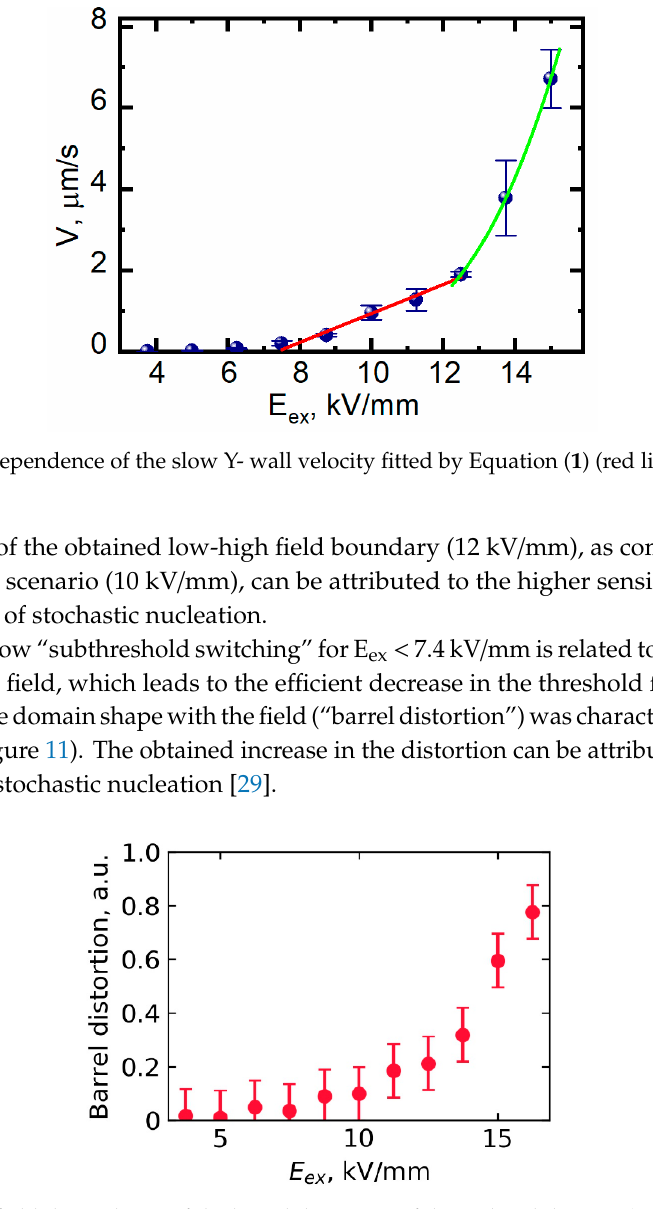
Figure 11. The field dependence of the barrel distortion of the isolated domain (see Appendix